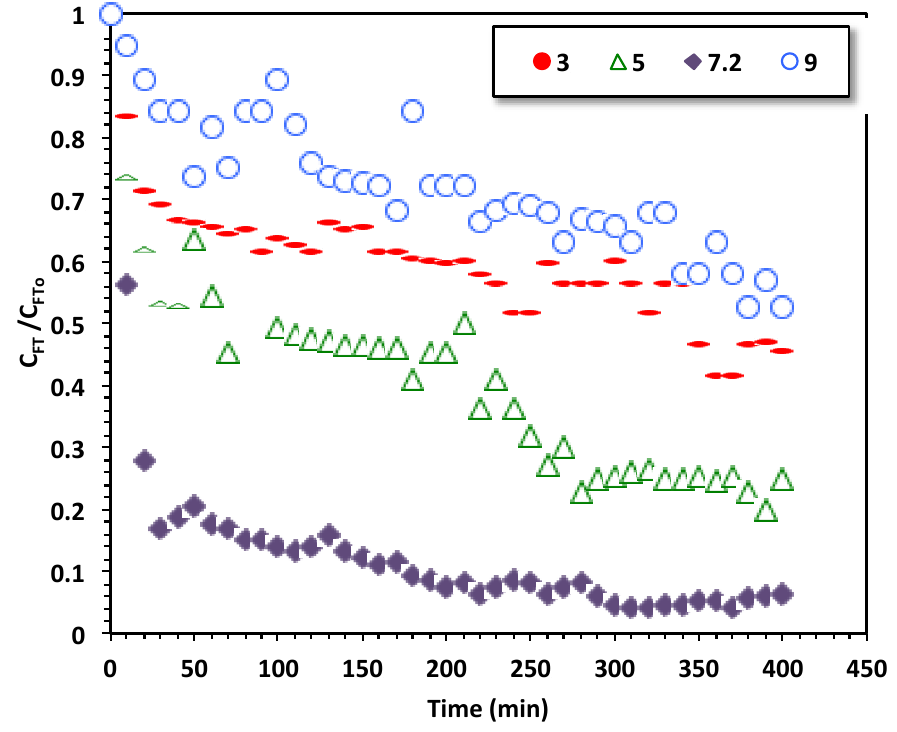
Figure 7. Effect of aqueous Flytek pesticide effluent pH on the uptake removal.